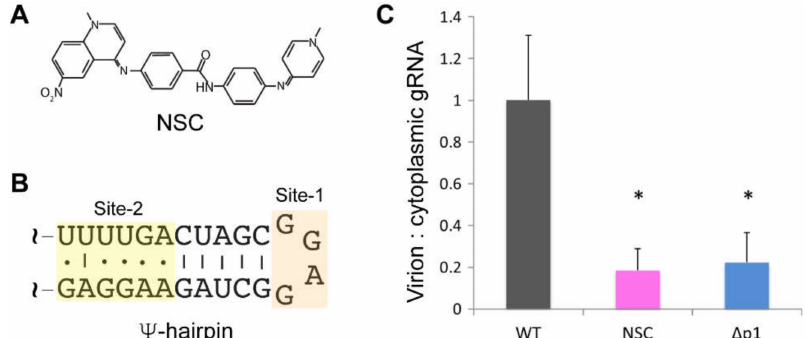
Figure 19. Small molecule inhibitor of HIV-1 genome packaging. ( A ) Structure of packaging inhibitor NSC. ( B ) Binding sites of NSC in the Ψ -hairpin of the HIV-1 packaging signal. ( C ) NSC treatment reduces HIV-1 selective genome packaging. Asterisks represent statistically significant from wild-type (WT) by Student’s t test, p < 0.05. Panel ( C ) reproduced from [394], with